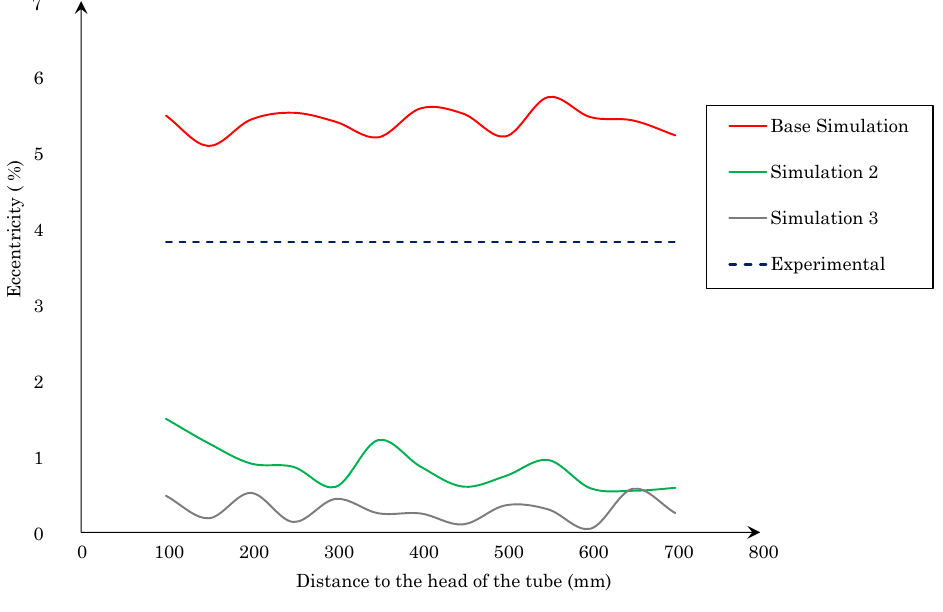
Figure 14. Numerical and experimental wall thickness eccentricity results of the three